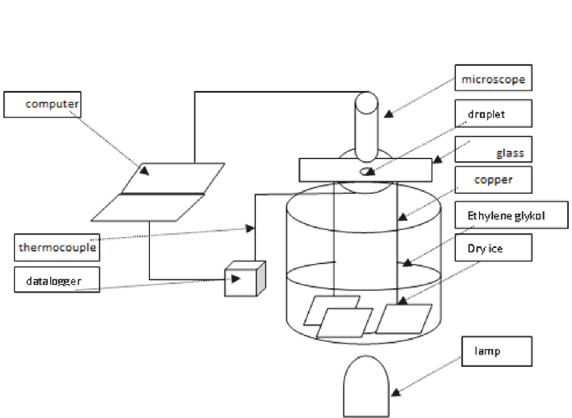
Figure 1: Experimental